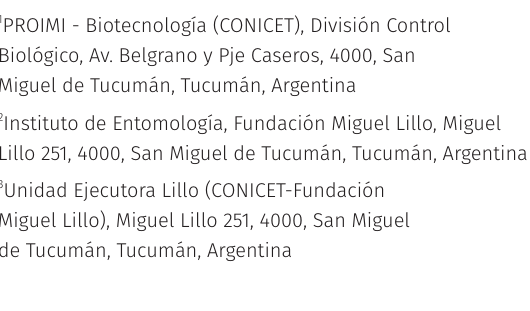
plants. se: standard error; ICC: intra-class correlation. Table SV. Summary of the generalized linear mixed model of the effects of leaf sector (basal blade, apical blade, basal midrib, apical midrib) in V4 plants on the emergence of parasitoids taking into account the number of parasitoids of Dalbulus maidis (offset) on experimental corn plants. The model accounted for random variation between plants. se: standard error; ICC: intra-class correlation. Table SVI. Summary of the generalized linear mixed model of the effects of leaf sector (basal blade, apical blade, basal midrib, apical midrib) in V4 plants on the emergence of Anagrus virlai parasitoids on experimental corn plants. The model accounted for random variation between plants. se: standard error; Table SVII. Summary of the generalized linear mixed model of the effects of leaf sector (basal blade, apical blade, basal midrib, apical midrib) in V4 plants on the emergence of Anagrus virlai parasitoids taking into account the emergence of other parasitoids (offset) on experimental corn plants. The model accounted for random variation between plants. se: standard error; ICC: intra-class correlation. Table SVIII. Summary of the generalized linear mixed model of the effects of leaf sector (basal blade, apical blade, basal midrib, apical midrib) in V4 plants on the emergence of other parasitoids (not Anagrus virlai ) on experimental corn plants. The model accounted for random variation between plants. se: standard error; ICC: intra-class correlation. Table SIX. Summary of the generalized linear mixed model of the effects of leaf sector (basal blade, apical blade, basal midrib, apical midrib) in V4 plants on the emergence of other parasitoid species taking into account the emergence of Anagrus virlai parasitoids (offset) on experimental corn plants. The model accounted for random variation between plants. se: standard error; ICC: intra-class